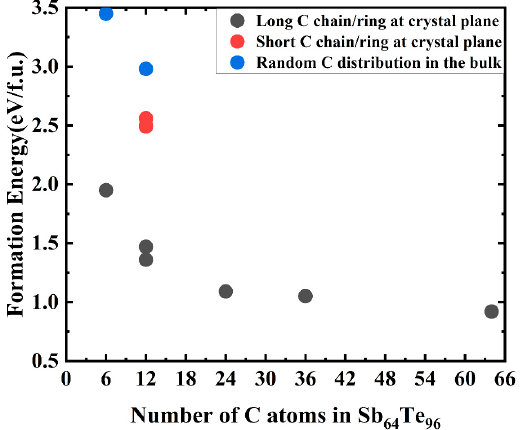
Figure 3. The formation energy of the Sb 2 Te 3 structure doped with different contents and different forms of C atoms/molecular clusters. The percentages of C atoms are 3.61%, 6.98%, 13.04%, 18.37%, and 28.57%, respectively.